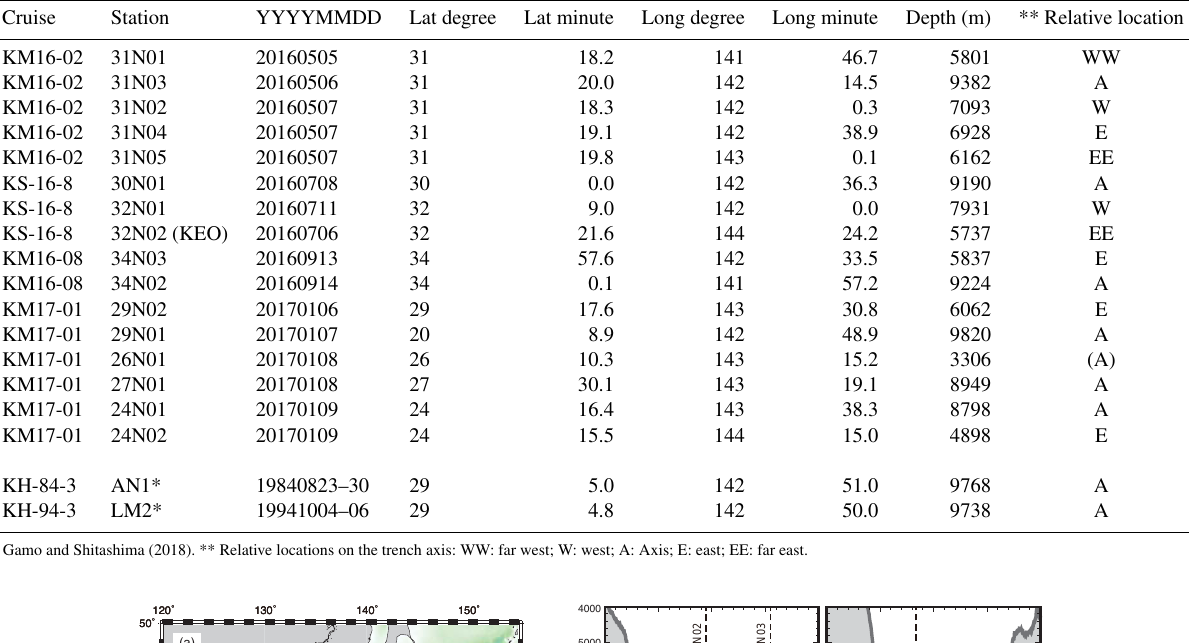
Table 1. Summary of stations.